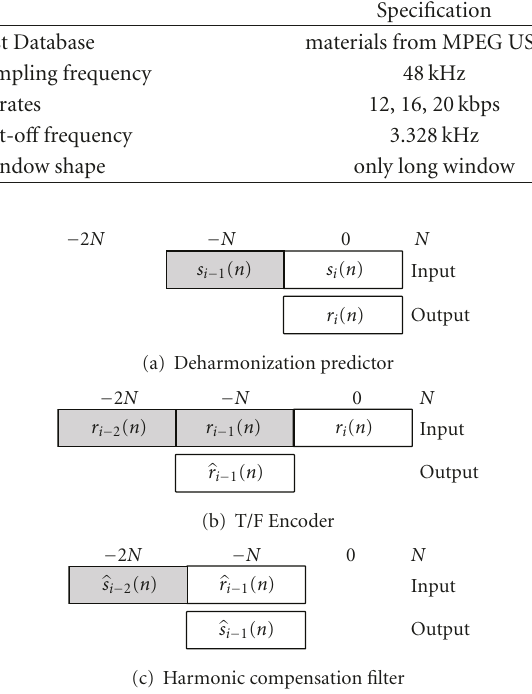
Figure 4: Encoder bu ff er of the proposed algorithm in each stage.